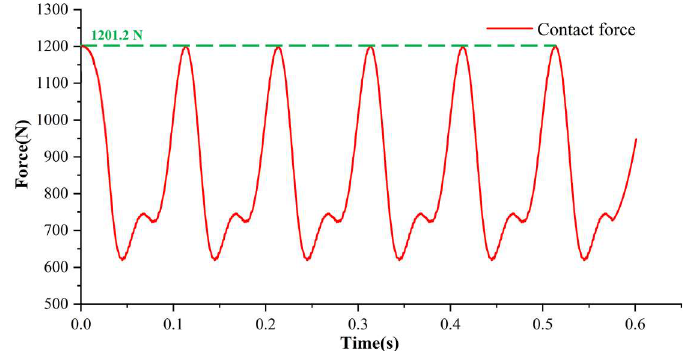
Figure 12. The curve of the torque of the torsion spring.